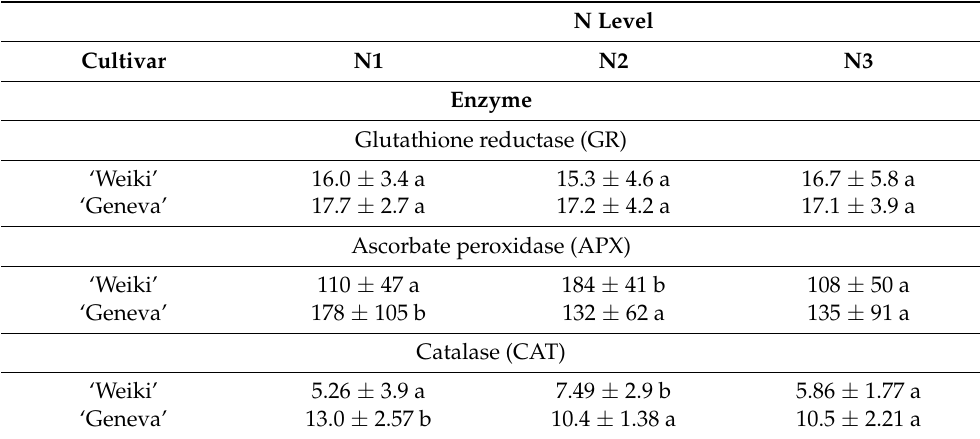
Table 5. Activity of antioxidative enzymes (nkat g − 1 FW) in A. arguta leaves depending on cultivar and soil N